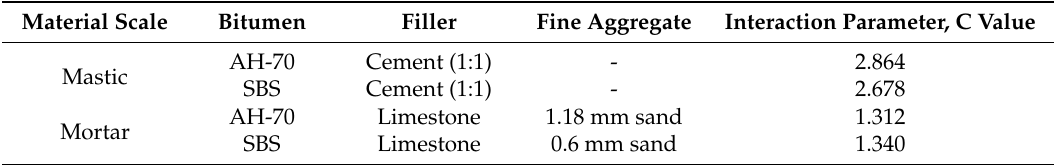
Table 7. Interaction validation by using cement as filler and river sand as a substitution for fine